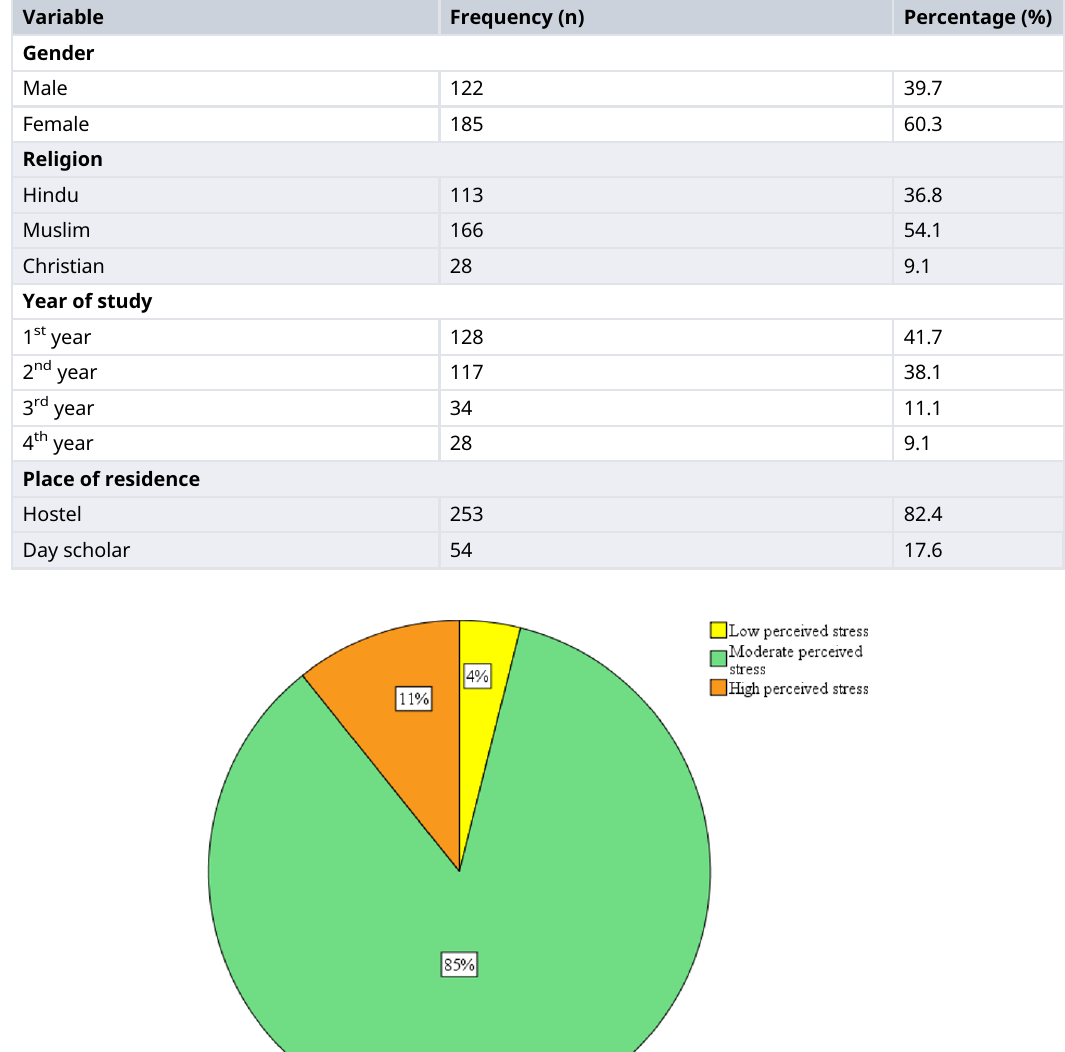
Table 1. Demographic characteristics of the participants (n = 307).